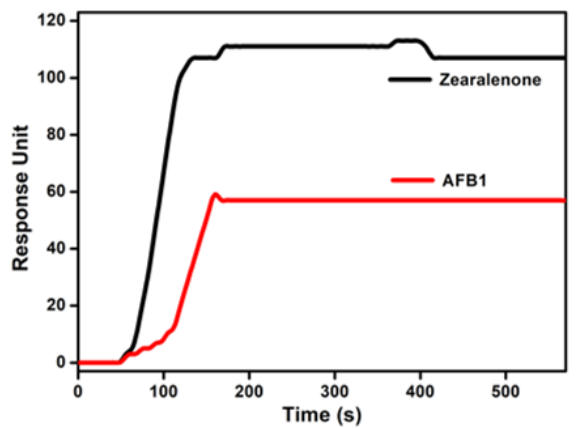
Figure 4. SPR response curves obtained in test channels after the detection of AFB1 and zearalenone, respectively. The concentration of both mycotoxins is 100 ppb. The SPR response was higher in the presence of zearalenone than in the presence of AFB1, indicating the selective detection of AFB1.